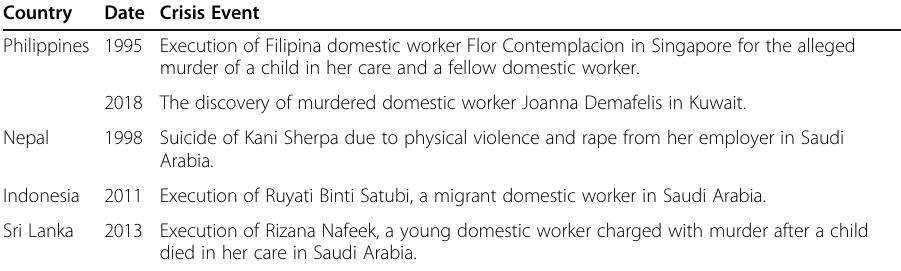
Table 1 Crisis Events Prior to Migration Bans Country Date Crisis